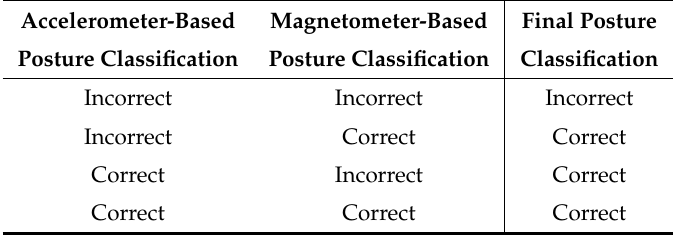
Table 1. Posture classification truth table.